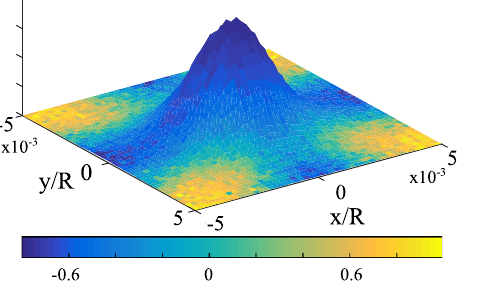
FIG. 11. Intensity-polarization graph for the plasma acceler- ation